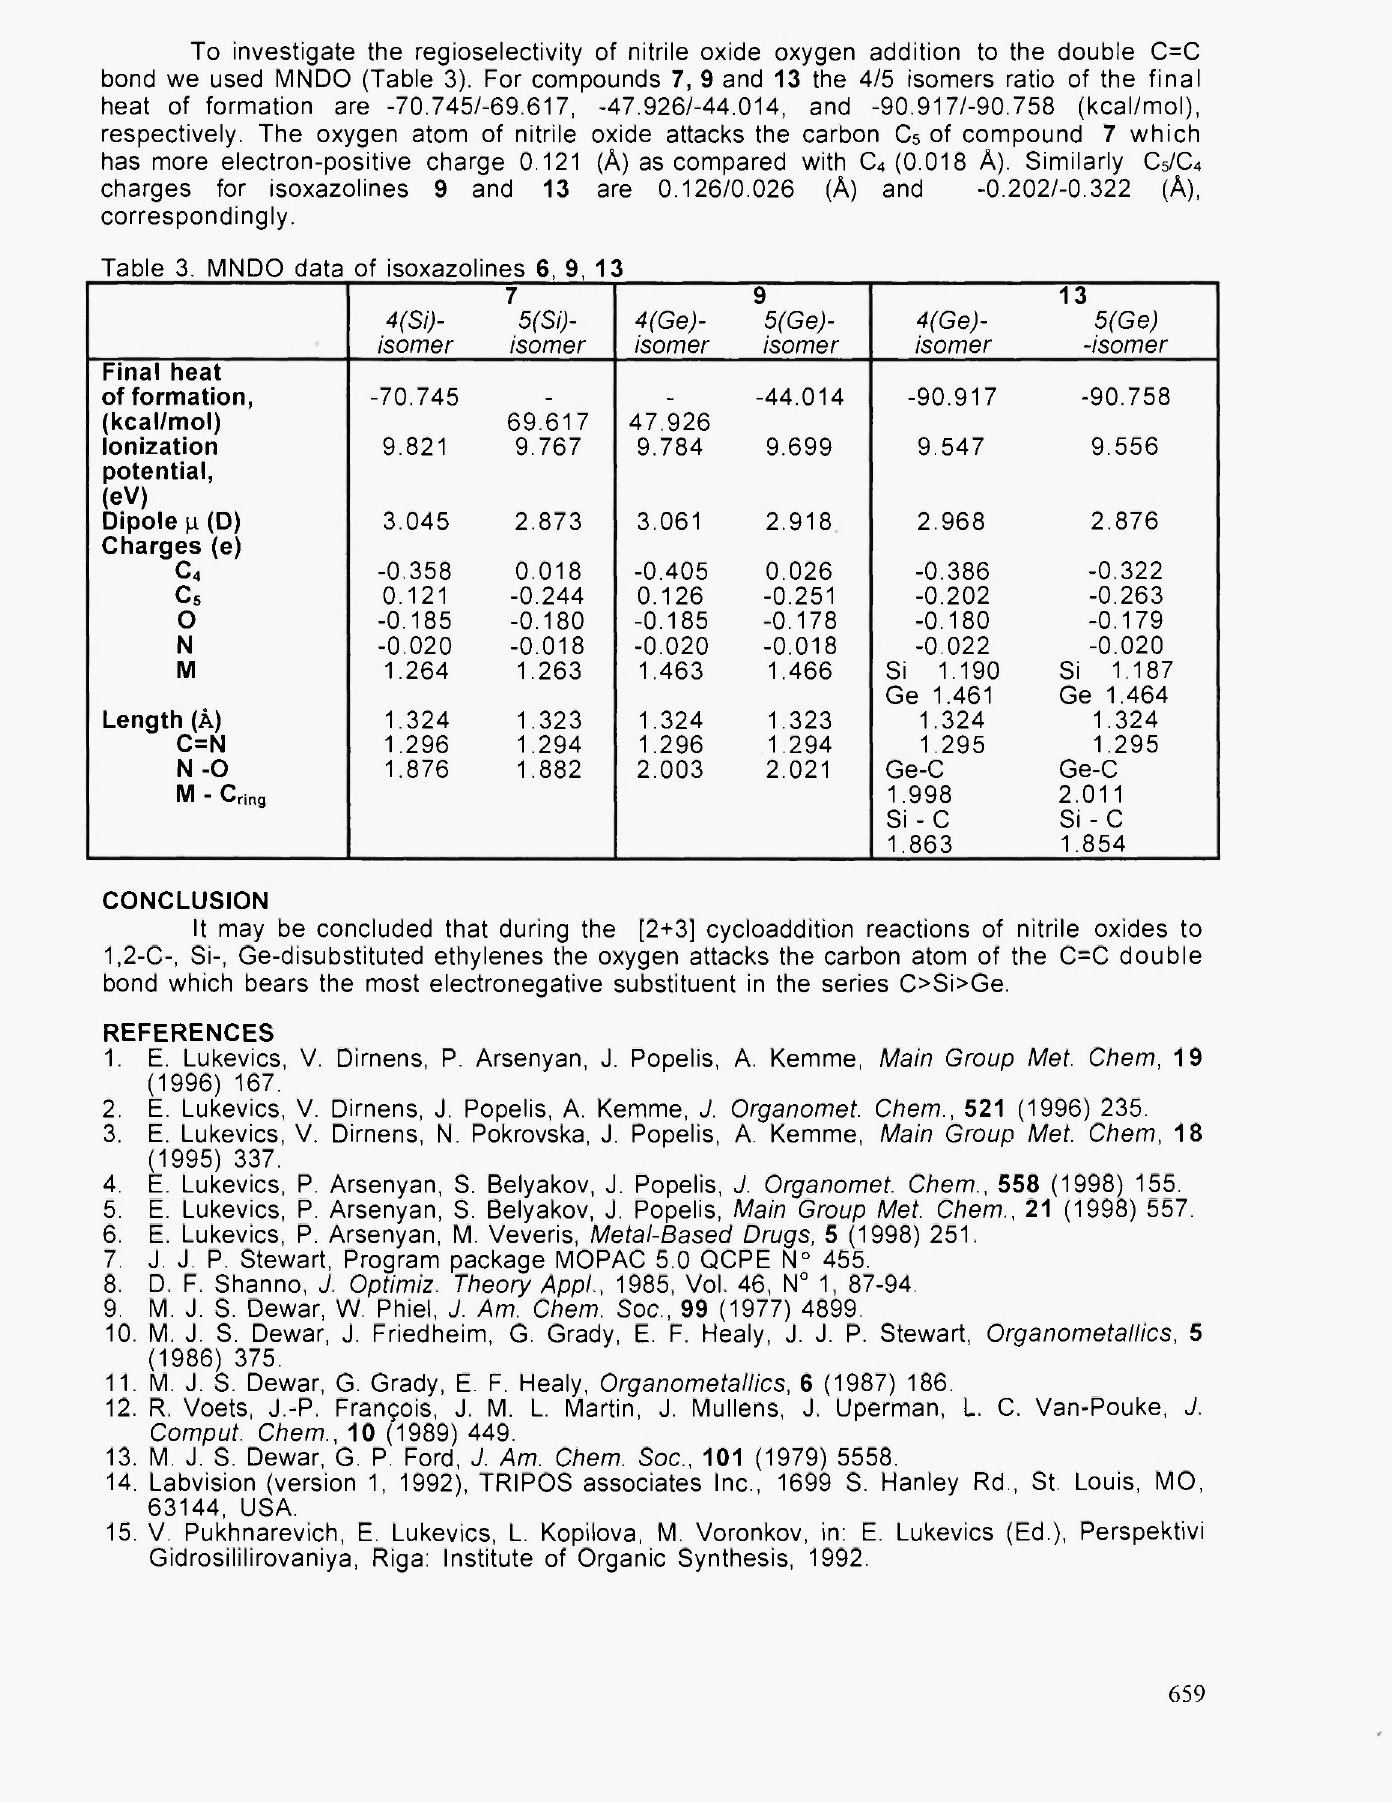
Table 3. MNDO data of isoxazolines 6, 9,